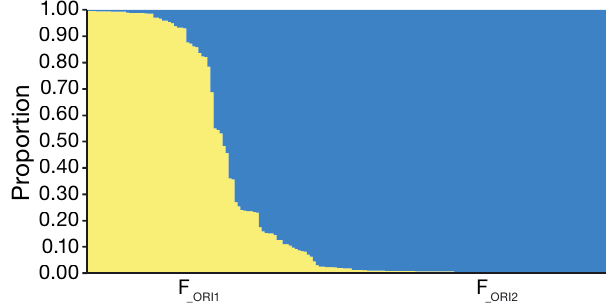
Fig. 1. STRUCTURE results for farmed samples of turbot showing 2 population units ( K) indicative of 2 genetic origins for domesticated individuals (yellow: F _ORI1 , blue: F _ORI2